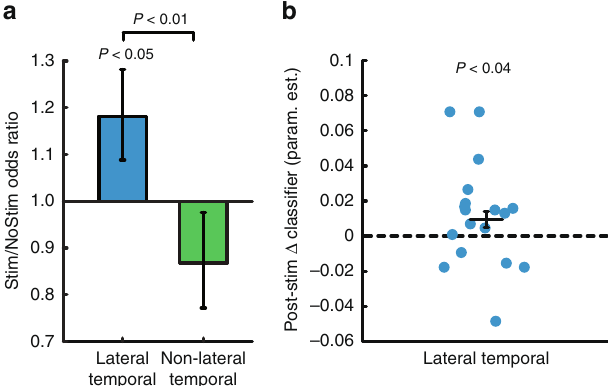
Fig. 3 Stimulation affects behavior and physiology. a Stimulation delivered to lateral temporal cortex targets increased the probability of recall compared to matched unstimulated words in the same subject ( P < 0.05) and stimulation delivered to Non-lateral temporal targets in an independent group ( P < 0.01). b The change in classi fi er output post-lateral temporal cortex stimulation was greater than for matched intervals on NoStim lists. Data are presented as model parameter estimate ± SE. Lateral